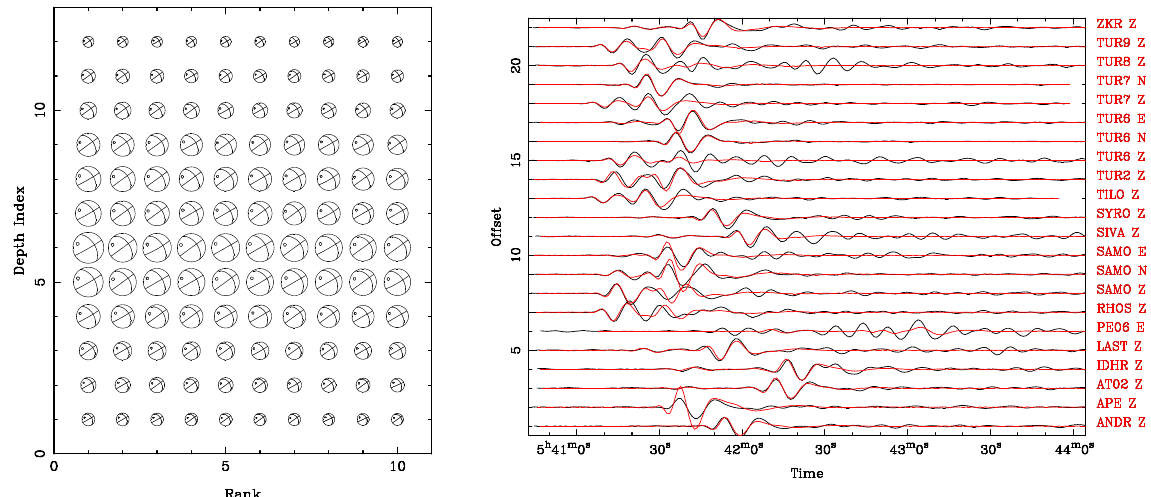
Fig. 2. Left: example of ranking of source mechanisms for an intermediate-depth earthquake at 135km depth. Each row of beach balls displays the 10 best solutions for a given source depth. The size of the beach ball is inversely proportional to the waveform misfit. Depths range from 160km at the bottom to 100km at the top. The small circle in the beach balls indicates the location of the tension axis. Right: example of the waveform fit for the intermediate-depth earthquake. Data are shown as black lines, shifted synthetic traces as red lines. Relative amplitudes of data and synthetic traces are correctly reproduced.